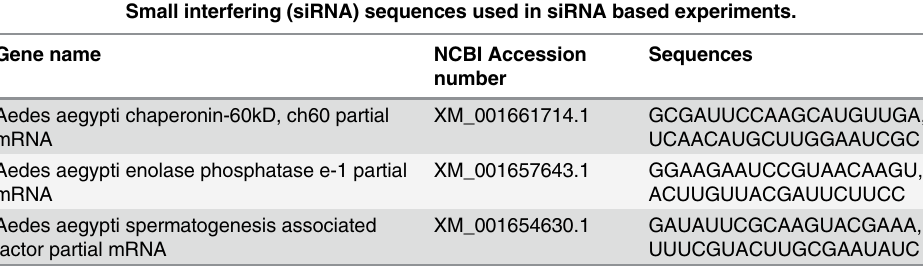
Table 3. Small interfering (siRNA) sequences used in siRNA based experiments. Small interfering (siRNA) sequences used in siRNA based